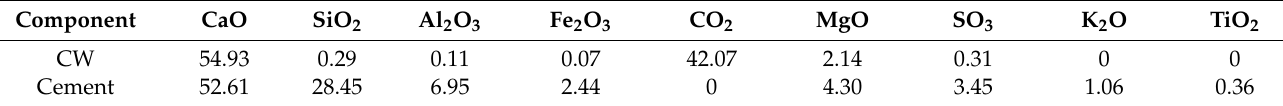
Table 1. The Chemical Composition of Composite Portland Cement and CW.